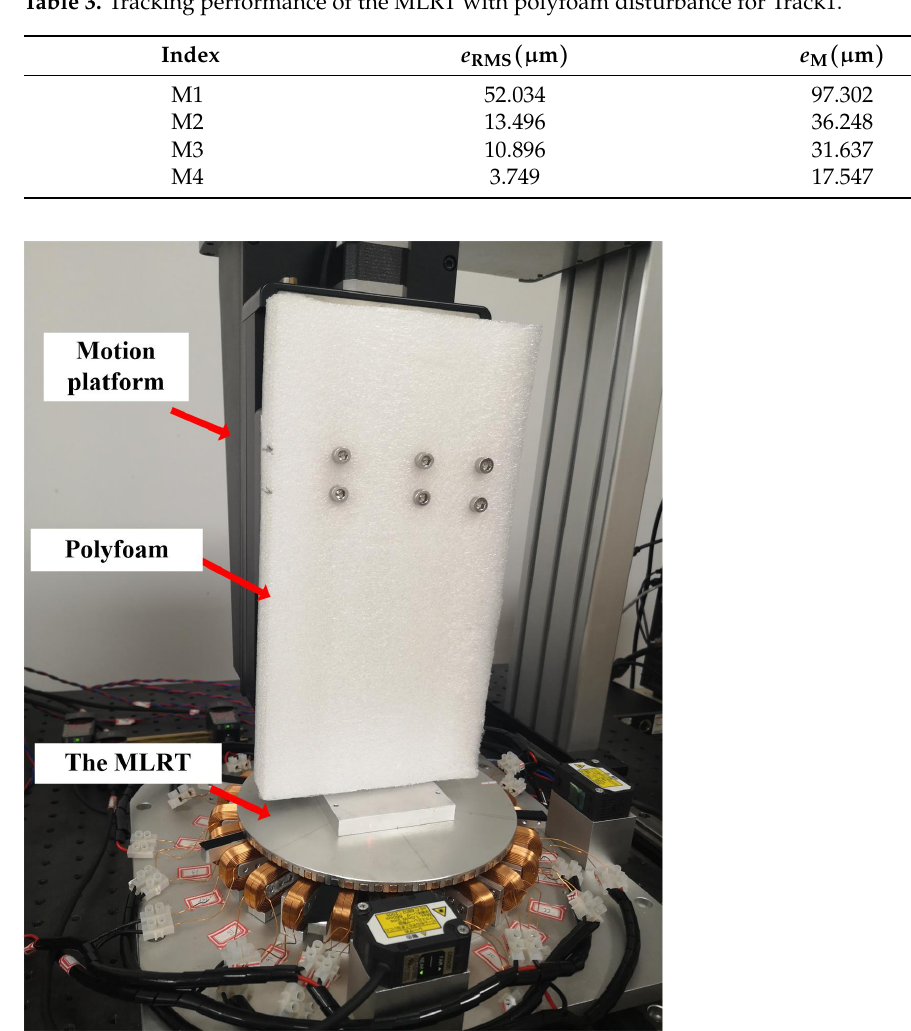
Table 3. Tracking performance of the MLRT with polyfoam disturbance for Track1.